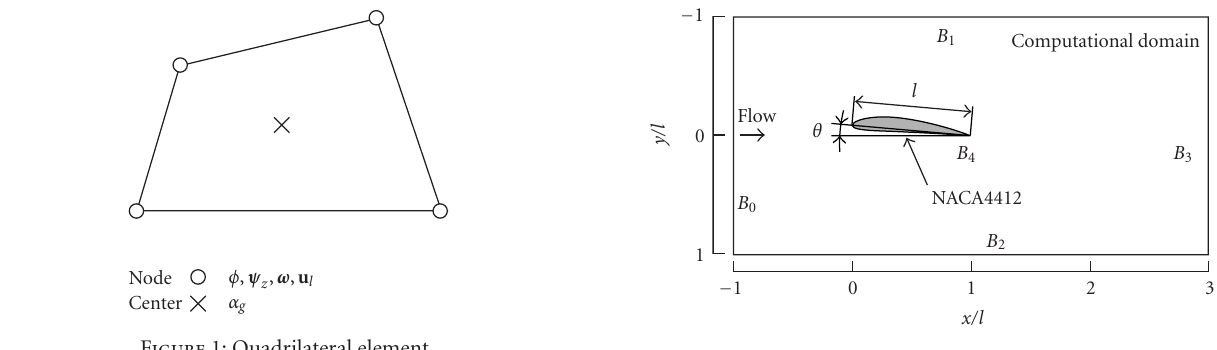
Figure 2: Computational